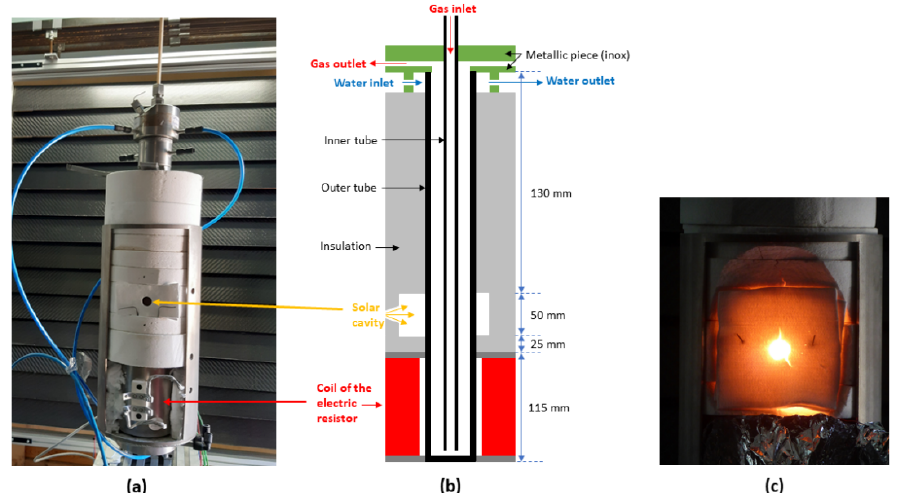
Figure 1. Hybrid solar/electric reactor installed at PROMES-CNRS (Odeillo, France): ( a ) real picture of the implemented reactor, ( b ) representative scheme of the reactor configuration, ( c ) photo of the hot cavity just after a solar run.